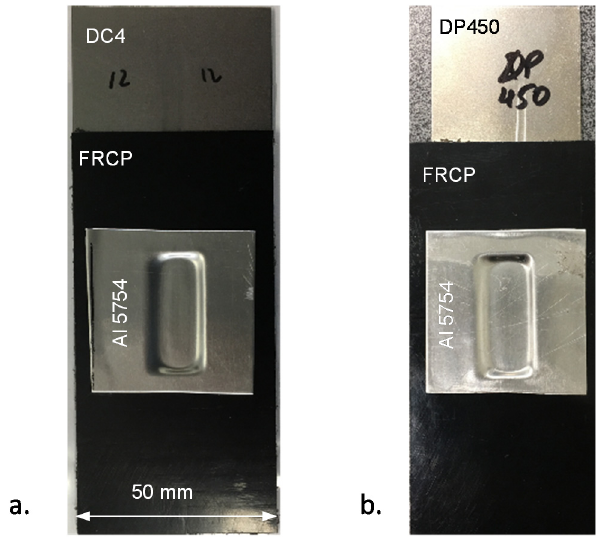
Figure 16. Joining FRPC to ( a ) DC04 and ( b ) DP450 steels; in both cases the metallic patch is an aluminum 5754 ( 𝑒 (cid:3033) = 0.5 mm).